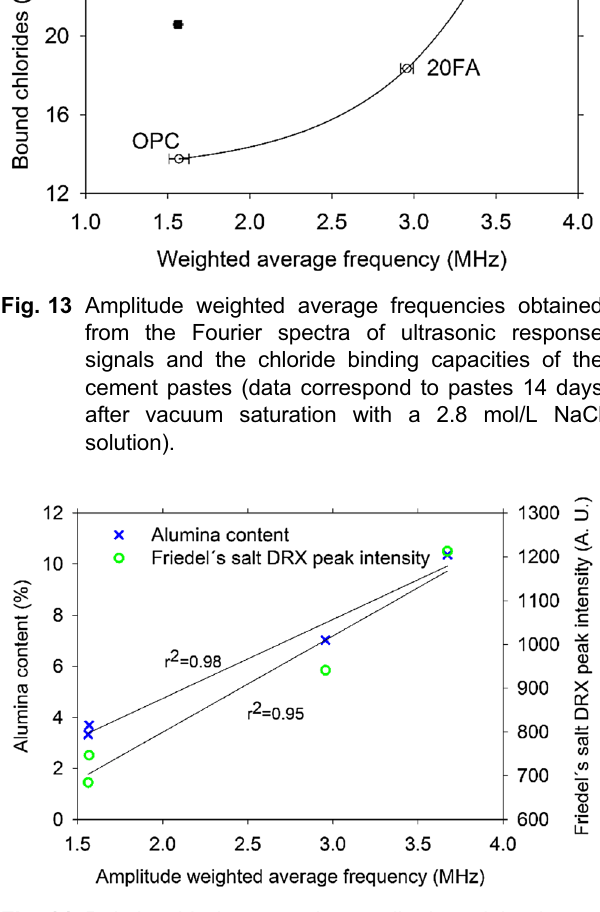
Fig. 14 Relationship between the amplitude weighted aver- age frequency and the quantities of alumina and Friedel’s salt present in the cement